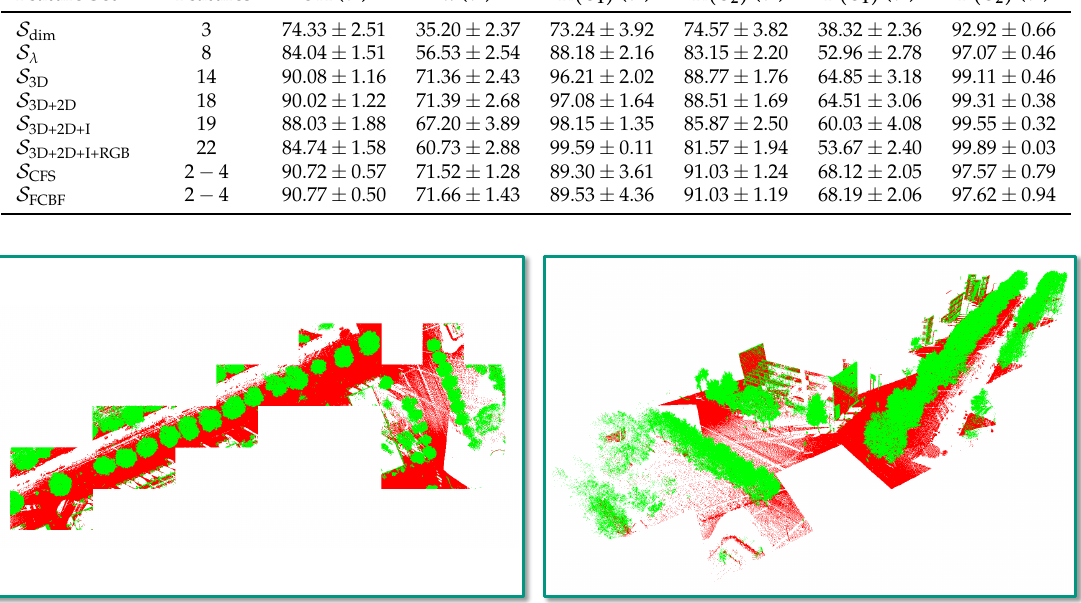
Table 2. Mean value and standard deviation for the different evaluation metrics (averaged across 20 runs): the class C 1 comprises “tree points”, whereas the class C 2 comprises “other points”. Feature Set